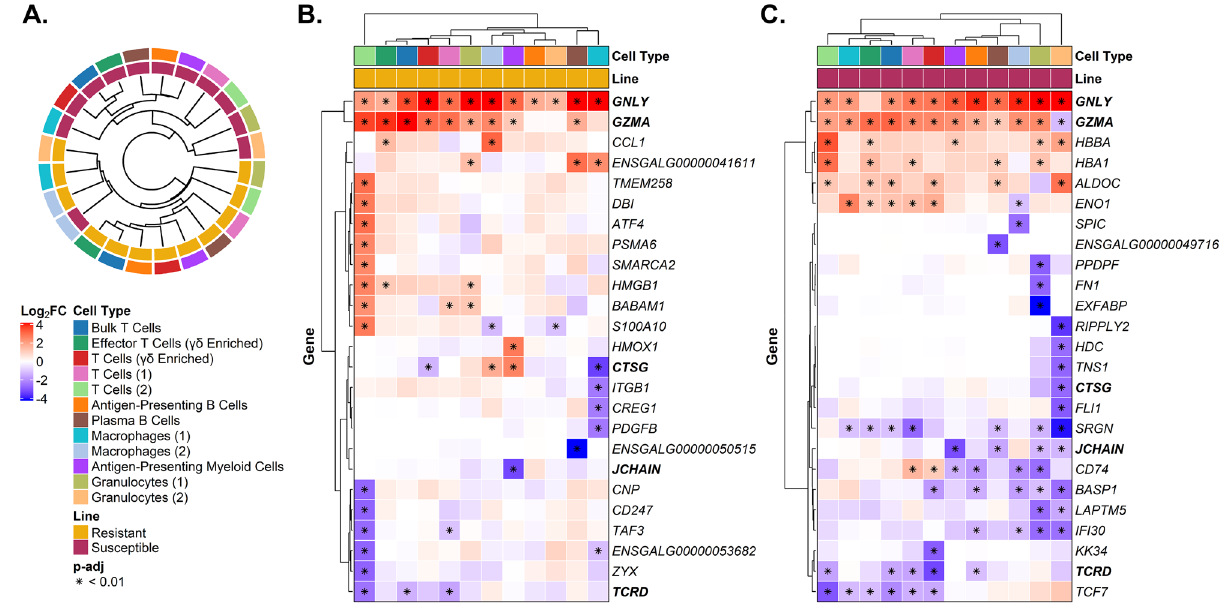
Figure 5. Genetic lines and cell types differ in their response to MDV infection. ( A ) Hierarchical clustering of each cell type in each line based on the log 2 fold change (log 2 FC; MDV-infected compared to control) of all genes with significant differential expression in at least one contrast (n = 964). ( B ) Log 2 FC across cell types for the top 25 differentially expressed genes (DEGs) in the resistant line (ADOL 6 3 ). ( C ) Log 2 FC across cell types for the top 25 DEGs in the susceptible line (ADOL 7 2 ). The magnitude of log 2 FC is shown according to the red-blue color scale. Cell type and genetic line are also annotated by color on the dendrogram and heatmaps.